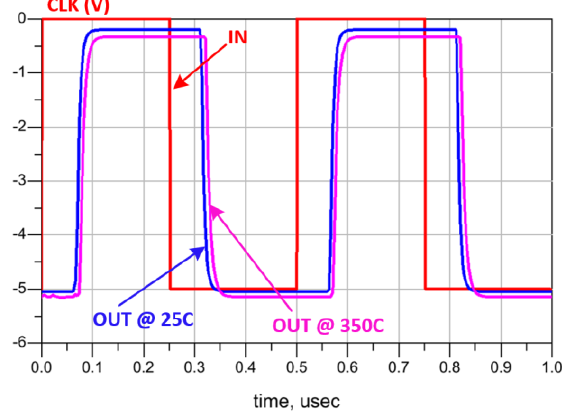
Figure 16. Temperature impact on DELAY circuit.